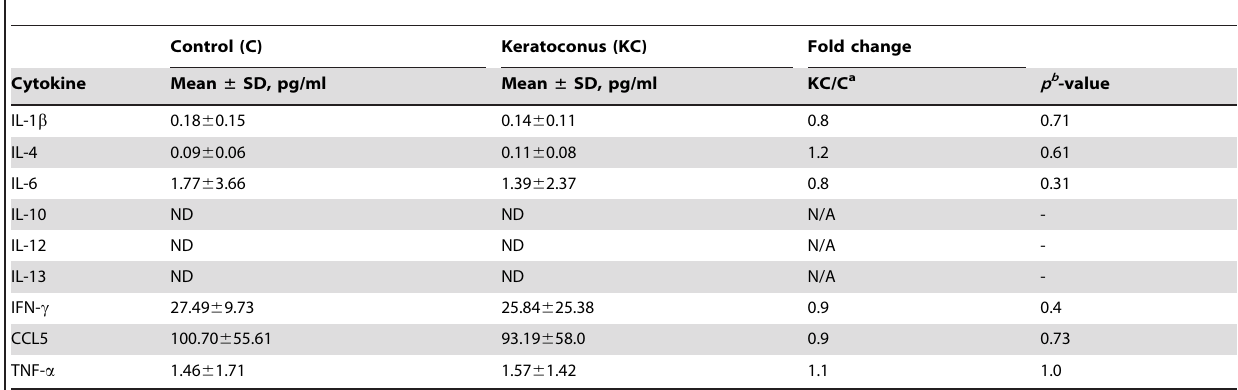
Table 4. Serum cytokine concentrations in keratoconus and control